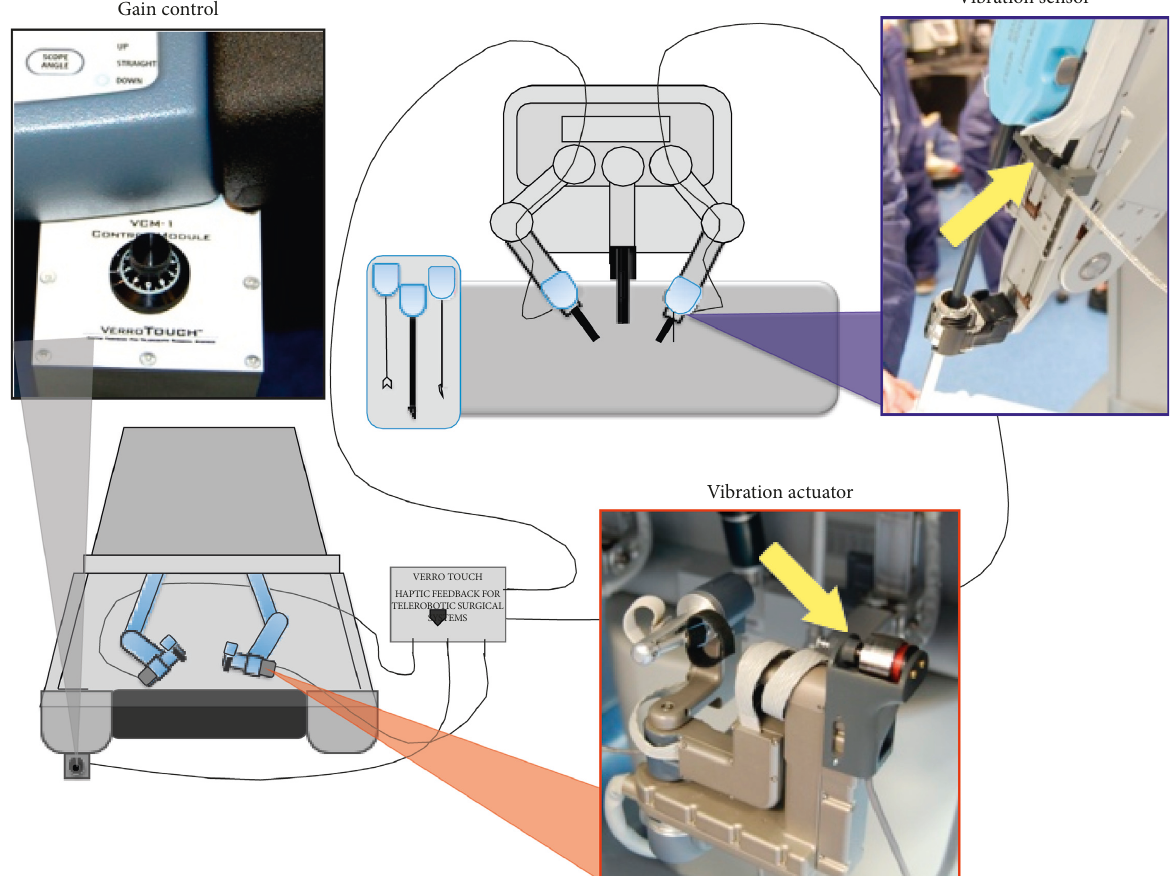
Figure 10: Schematic of Verro-Touch installed on an Intuitive da Vinci S surgical system (adapted with permission from Ref. [109]; copyright 2010, Springer publishing group).